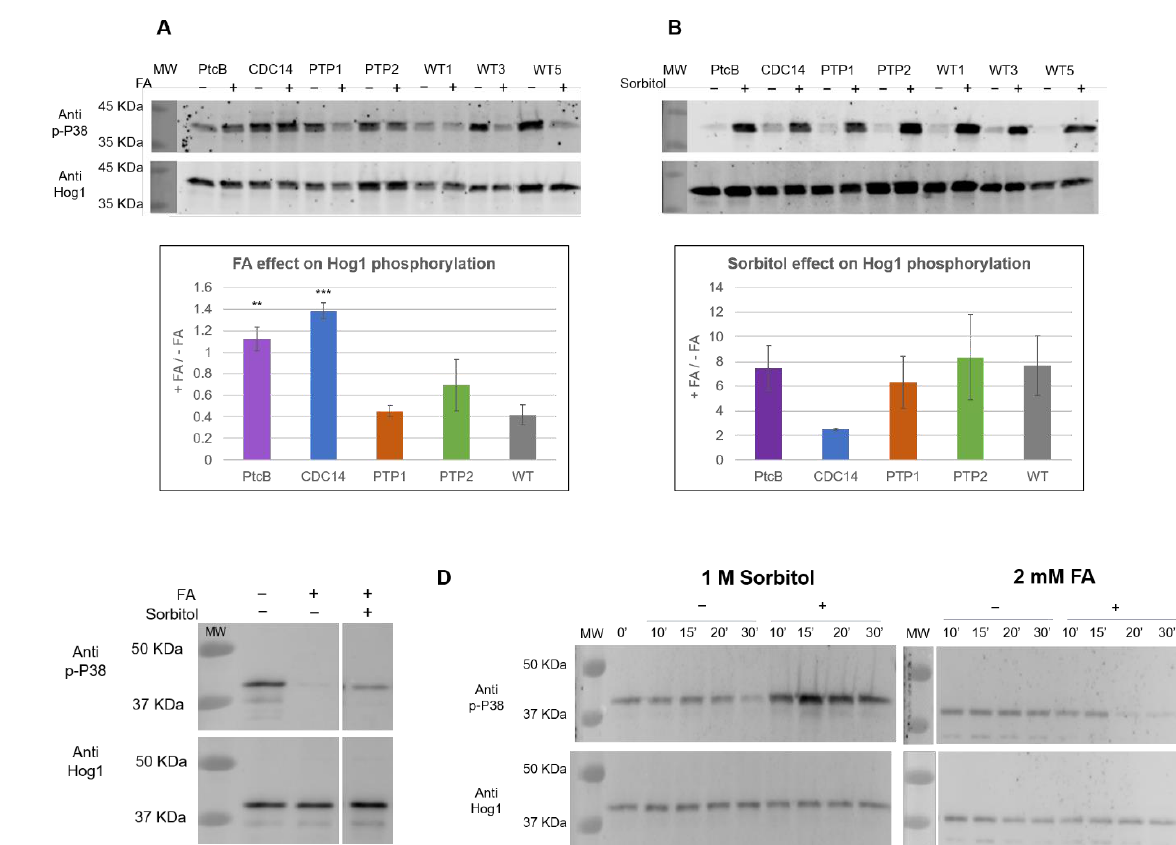
Figure 10. FA and sorbitol’s effects on Hog1 dual phosphorylation in WT and phosphatase mutants, assayed by immunoblotting. ( A ) FA, ( − ) indicates CM with 0.15% v/v DMSO (control); (+) indicates the addition of 2 mM FA. ( B ) Sorbitol, ( − ) indicates CM; (+) indicates the addition of 1 M sorbitol. Blots of the total protein extract of the WT and the different mutants were probed with either a p-P38 antibody (Cell Signaling, T180-Y182, 9211S) or a Hog1 antibody (Santa Cruz, y-215, sc-9079). Representative blots are shown (for the complete data set, see supplementary Figure S5). The graphs represent the ratio change in the signal upon induction (calculated from three independent deletion transformants, indicated by numbers labelling each lane). The quantitation was performed using Image J. The t -test p -values of each strain vs. the WT were calculated, and are marked as follows: p -value < 0.05—**; p -value < 0.01—***. ( C ) The sequential effect of FA and osmotic stress on Hog1 in WT. The samples were analyzed as in panels ( A , B ). C. heterostrophus C4 WT strain protein extract, from CM with 0.15% v/v DMSO (−/−), CM with 0.15% v/v DMSO with 2 mM FA (+/−), and CM with 0.15% v/v DMSO with 2 mM FA, with the sequential addition of sorbitol to 1 M concentration, as described in the method section (+/+). In this panel, different parts of the same blot are shown side by side at the same scale, and this is indicated by a space between the sections. ( D ) Time course for the sorbitol and FA induction. The media and immunoblotting were as they were in panels ( A , B ).